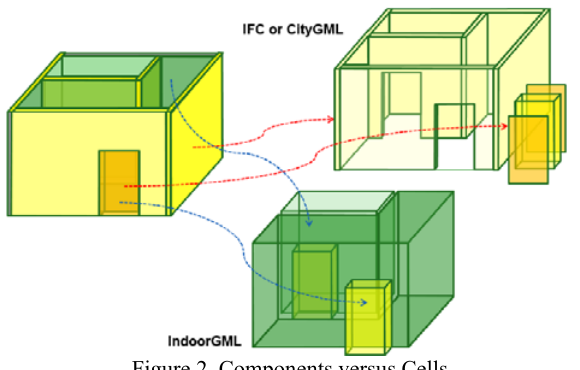
Figure 2. Components versus